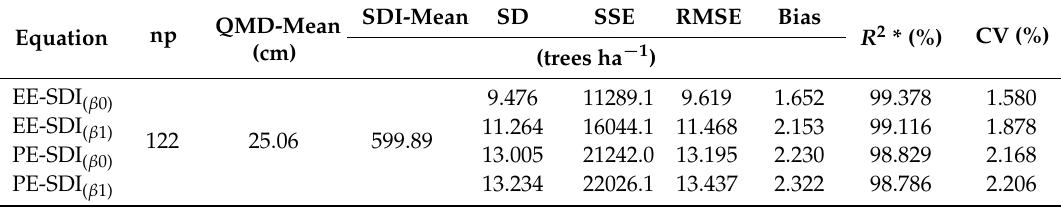
Table 5. Validation statistics of the exponential and potential equations for each SDI.